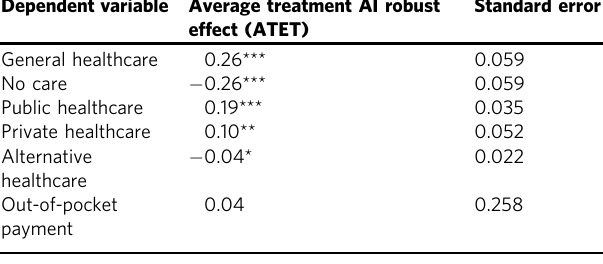
Table 7 Propensity score matching of the effect of NHIS on healthcare utilization (by types) and out-of-pocket